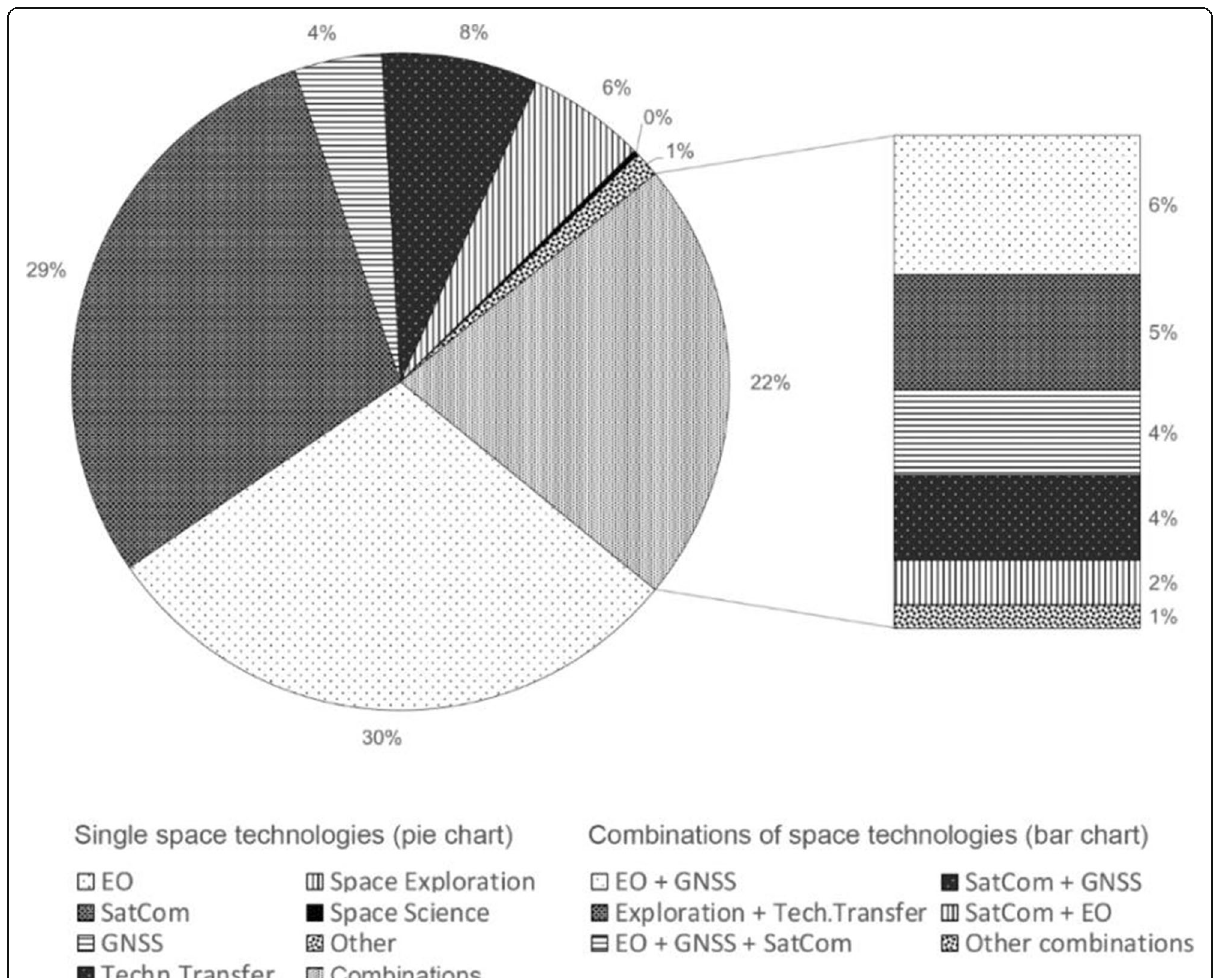
Fig. 7 Breakdown of the contributions of individual space technologies (pie chart) and combinations thereof (bar chart) to the sum of projects. Combinations that make up less than 1% of all combinations are summarized in the category “ Other combinations ” . Percentages in parentheses are relative to the sum of technology combinations. The percentage values have been rounded to the nearest